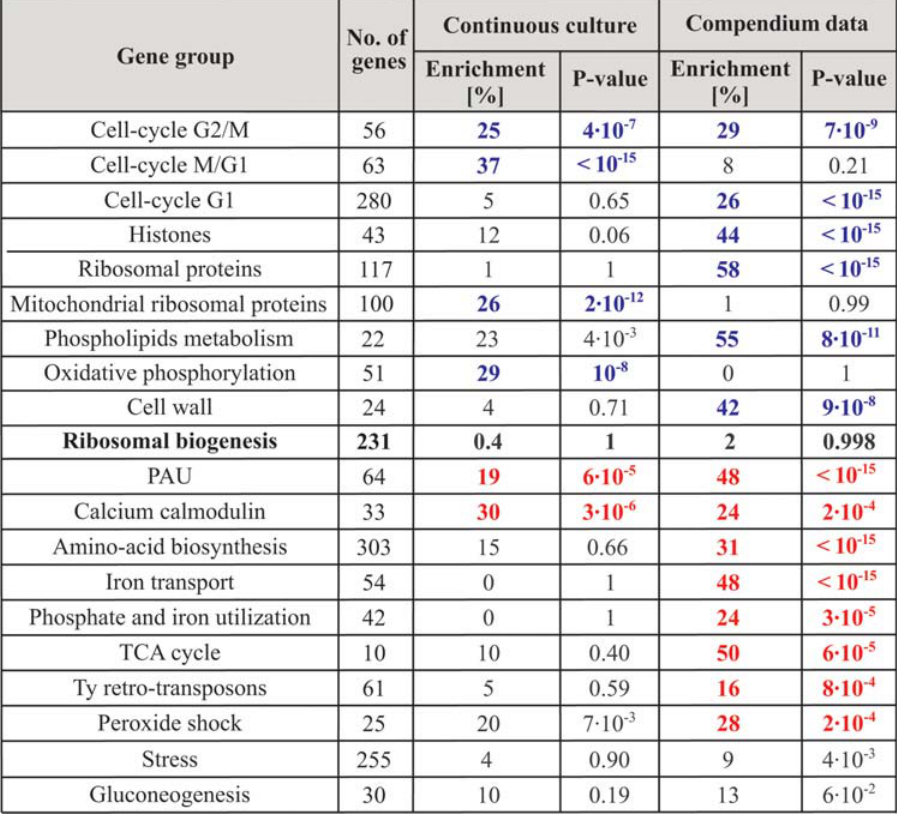
Figure 4. Enrichment of positive and negative correlated genes with previously defined gene modules. The table summarizes the analysis which spanned over hundreds of gene modules. For each gene group and experiment we calculated the enrichment with the positive (blue) and negative (red) correlated genes. Note that none of the gene modules were enriched with both positive and negative correlated genes and only the highest score is displayed. Less significant enrichments are shown in black (P-value . 10 2 3 ) (see also Tables S3).